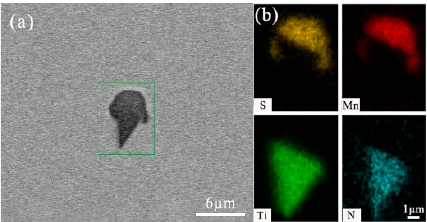
Figure 6. Typical MnS diagram associated with TiN precipitation ( a ) SEM morphology of inclusions; ( b ) composition distribution of inclusions.